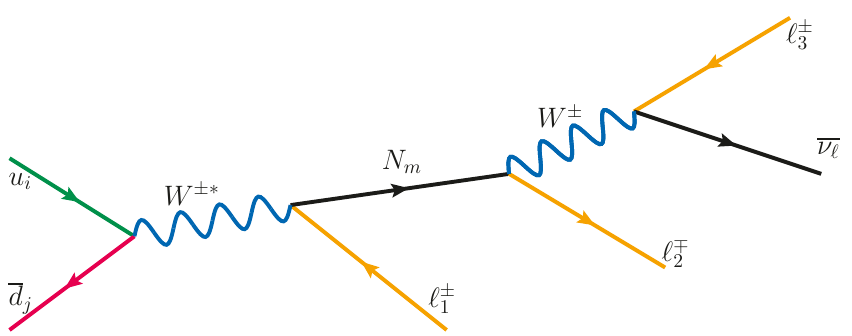
Figure 2. Born diagram for charged current Drell-Yan production of heavy N with subsequent decay to the three charged lepton (trilepton) (cid:12)nal